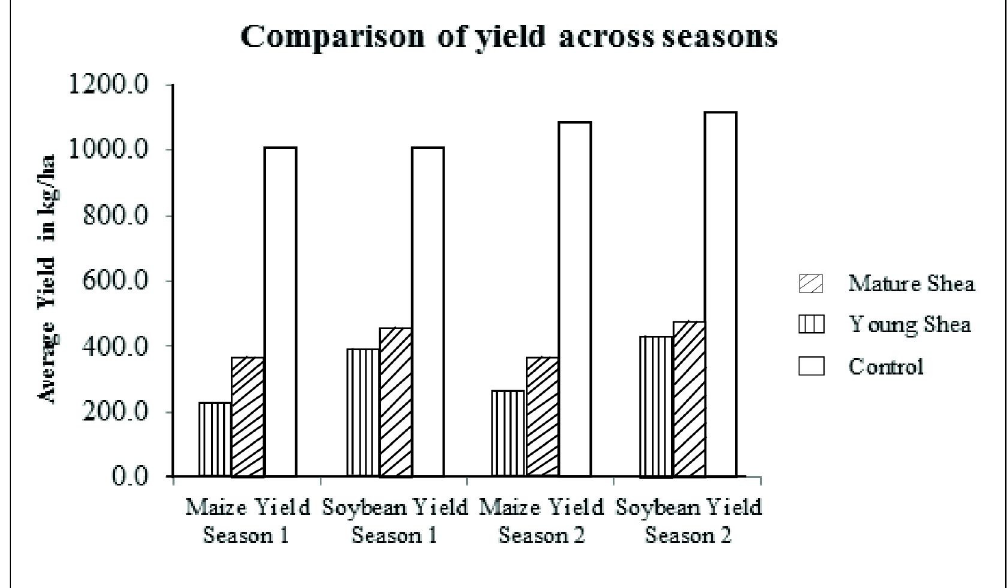
Fig 2. Maize and Soybean yields under different Shea ages across two